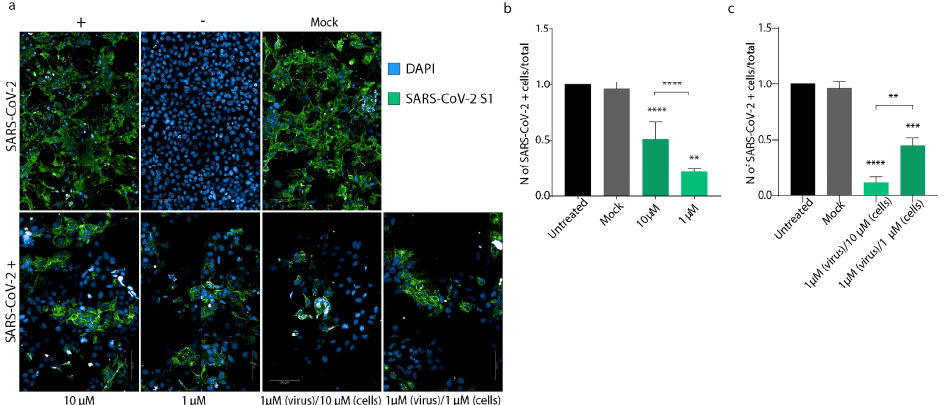
Figure 6. PEA decreases SARS-CoV-2 entry. ( a ) High-content confocal microscopy analysis of SARS- CoV-2-infected cells (green) treated or not with PEA. Representative images of Huh-7 cells infected or not with SARS-CoV-2 and treated or not with PEA 1 and 10 μ M. ( b , c ) Statistical analyses of the numbers of SARS-CoV-2+ cells, normalized to untreated controls. Ninety fields per well were ana- lyzed using a 40× water objective. Data are expressed as means ± SD and were analyzed by Student’s t test (n = 3, ** p < 0.01; *** p < 0.001; **** p < 0.0001). To further confirm the antiviral activity of PEA, we decided to perform the same analysis shown in Figure 6 on Calu-3 cells, another cell line that is widely used for SARS-